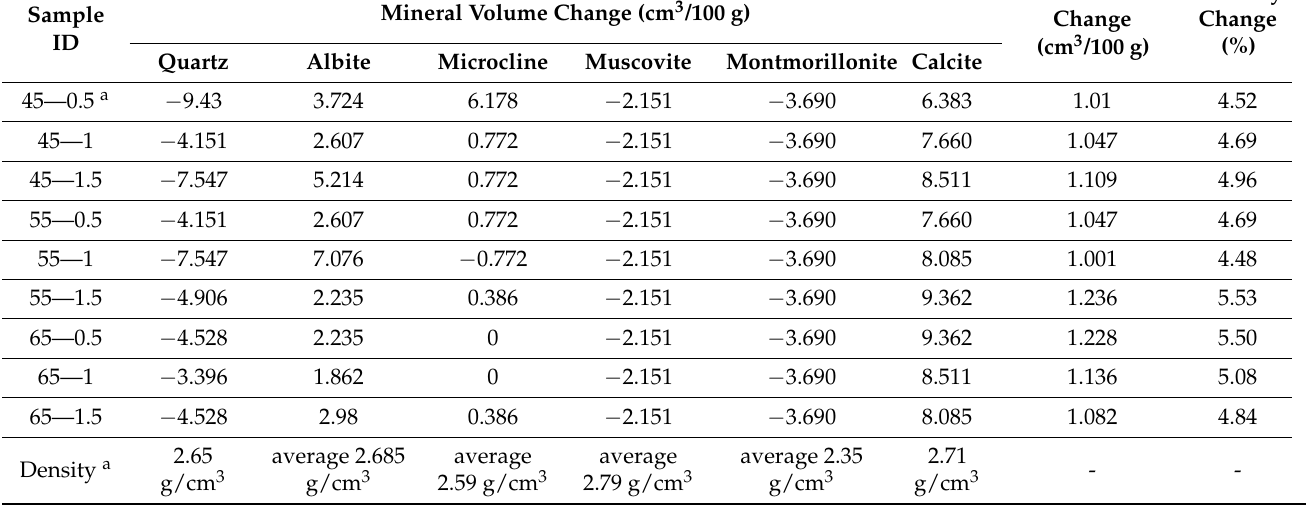
Table 6. Mineral volume and porosity change under different conditions. a. Referenced in the National Infrastructure of Mineral, Rock and Fossil for Science and Technology